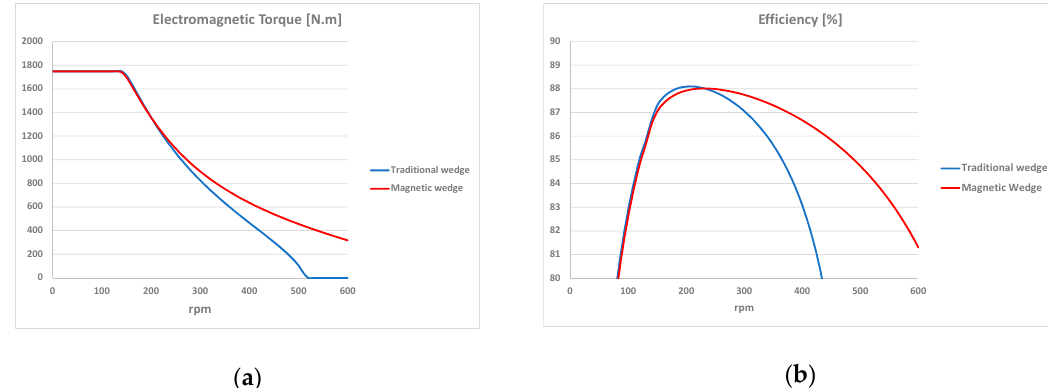
Figure 15. ( a ) Electromagnetic torque at variable speed; ( b ) Efficiency at variable speed.